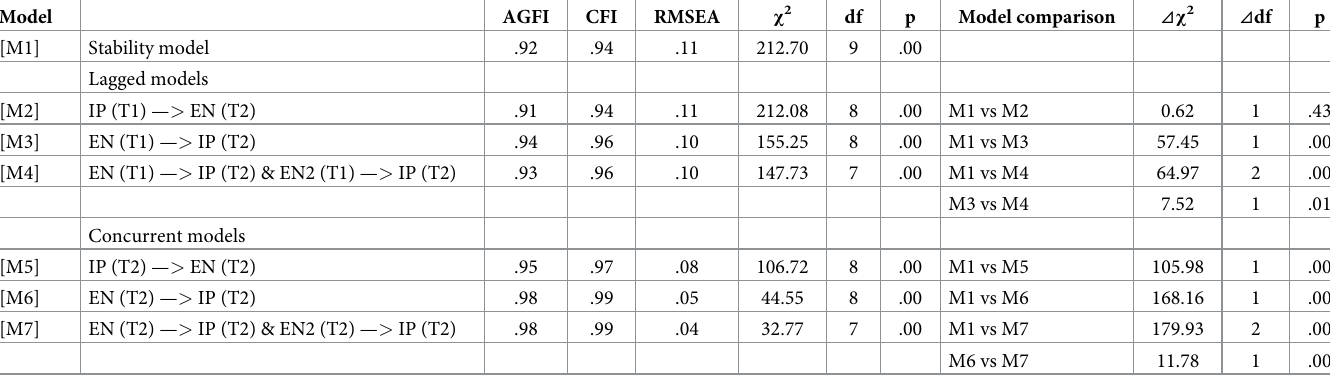
Table 3. Longitudinal relations between work engagement and in-role performance (N = 1,967).